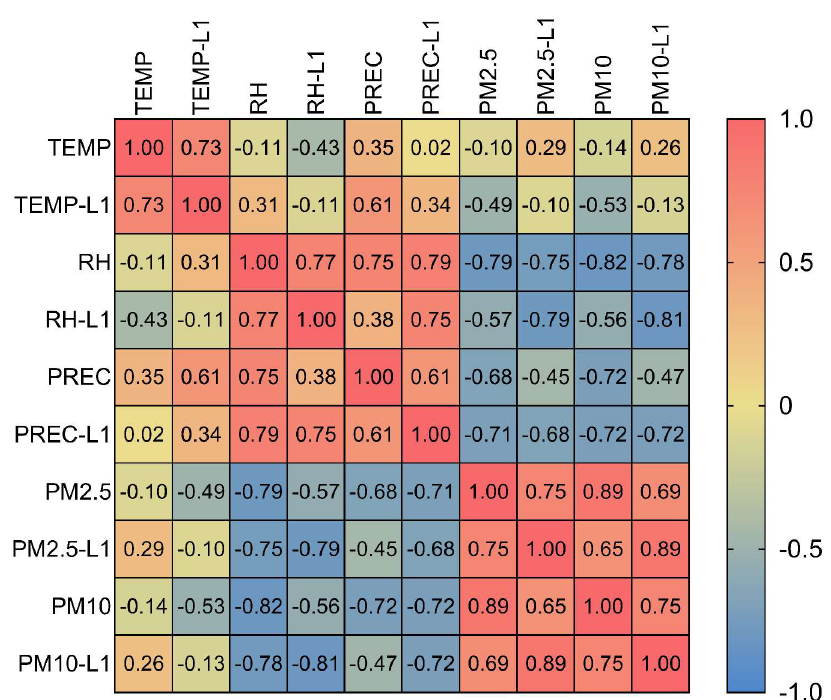
Figure 5. Spearman’s correlation matrix among environmental variables. TEMP, temperature; L1, lag1; RH, relative humidity; PREC, precipitation (rainfall).